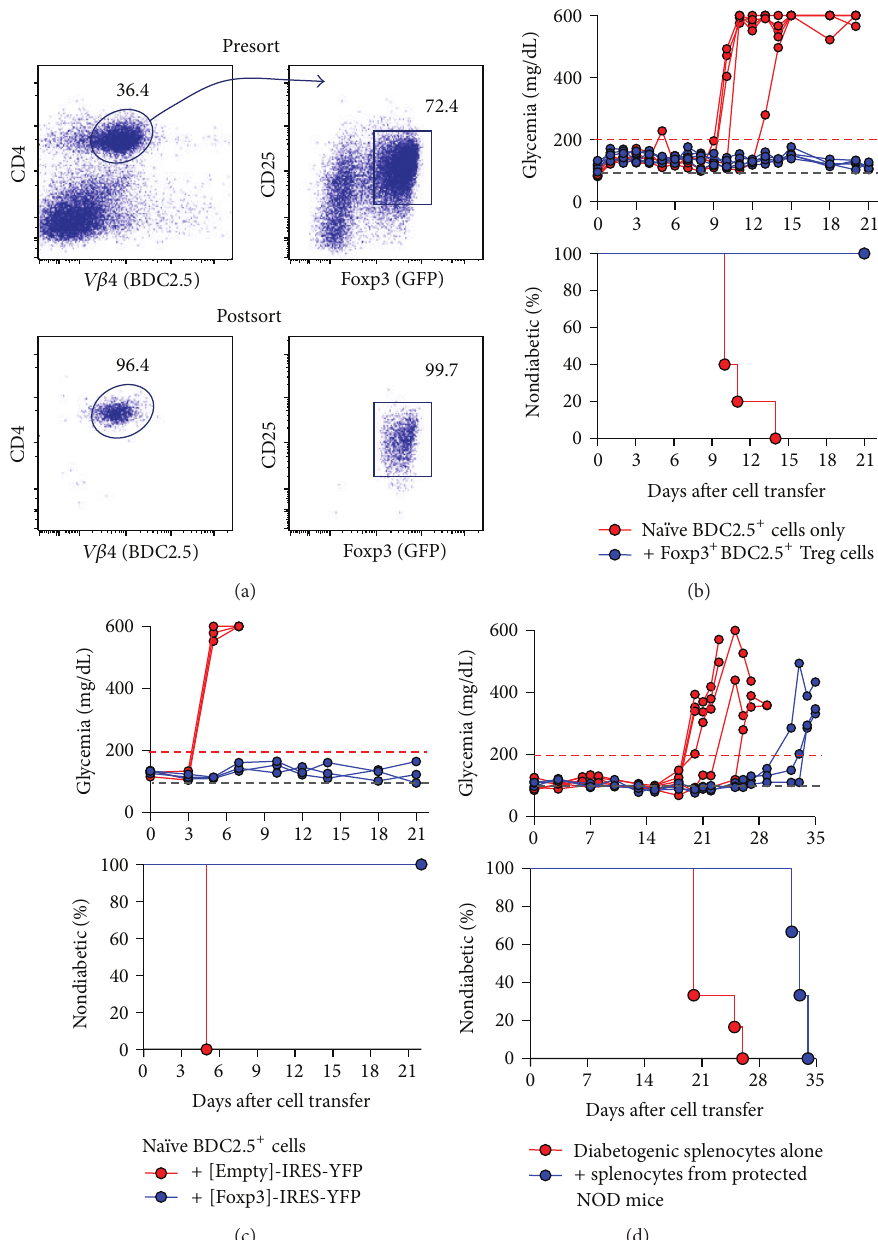
Figure 3: Foxp3 + Treg cells in NOD transfer models. (a–c) Adoptive BDC2.5 + T cell transfer. (a) FACS purification of BDC2.5 + Foxp3 +